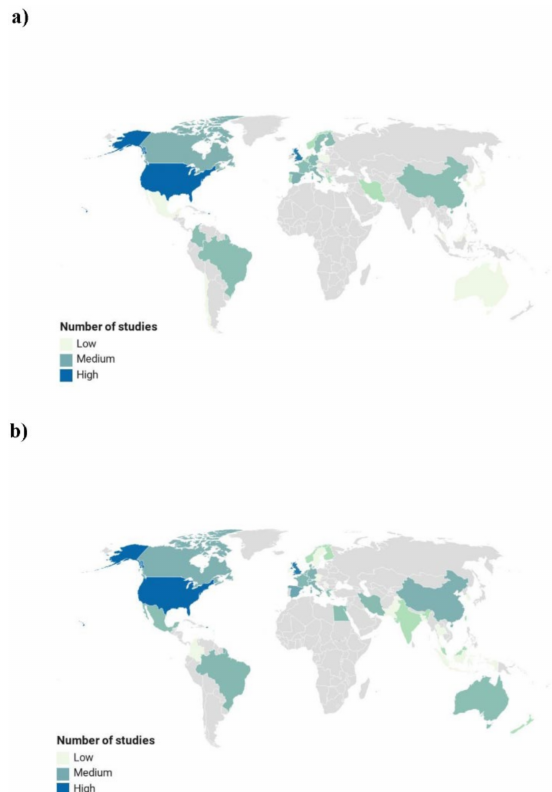
Figure 9. Countries with the highest number of registered studies on polyphenol-rich foods ( a ) and extracts ( b ). Legend: “low”: < 10 registered trials; “medium”: 10–49 registered trials; “high”: > 50 registered trials. Locations not reporting clinical trials on polyphenols are colored in